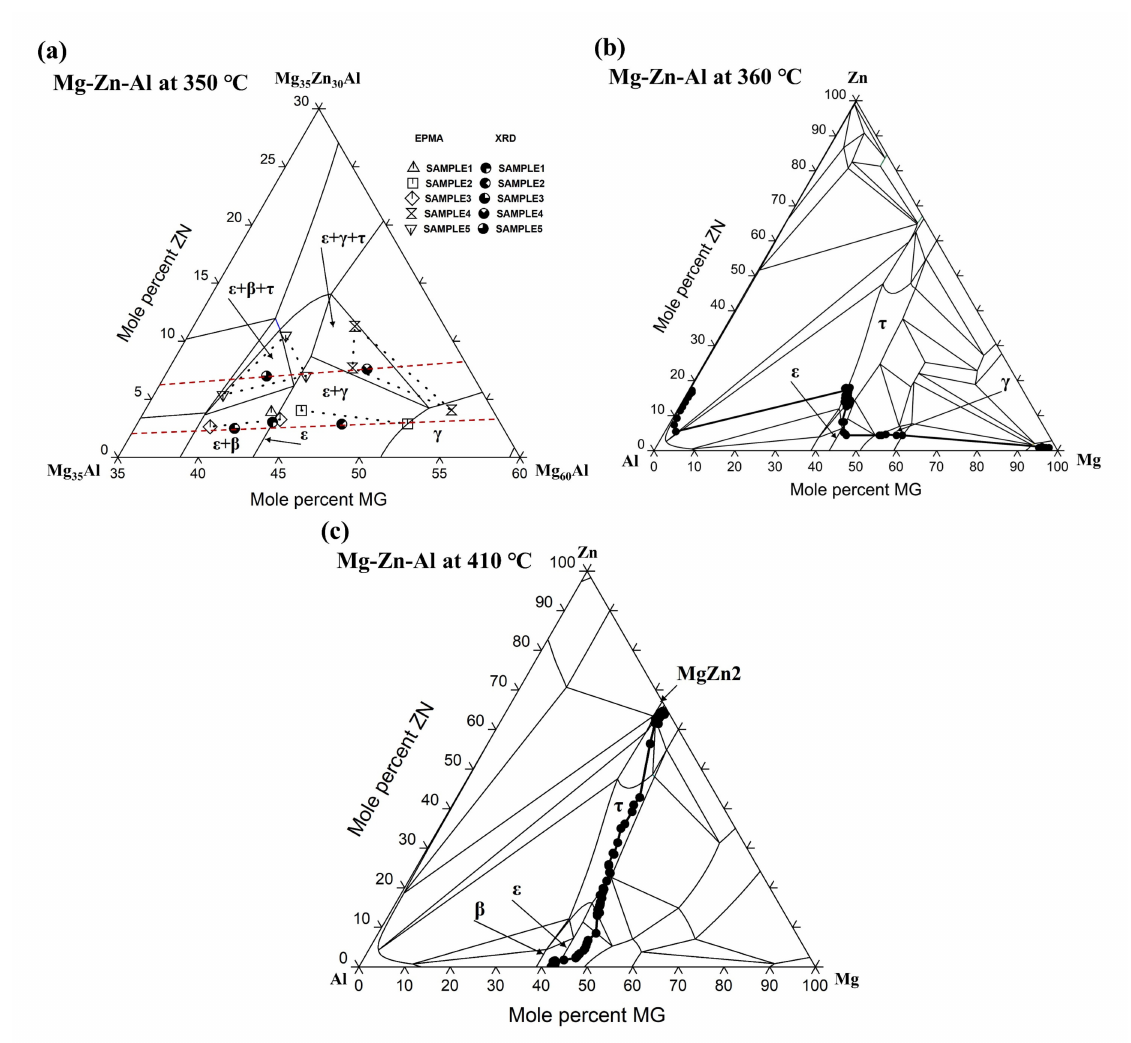
Figure 3. Isothermal section of the Mg-Zn-Al system ( a ) close to the ε phase calculated at 350 ◦ C along with the data from XRD and EPMA; ( b ) calculated at 360 ◦ C along with the diffusion profile of Al-Mg20Zn from literature; ( c ) calculated at 410 ◦ C along with the diffusion profile of MgZn 2 -Al 3 Mg 2 diffusion